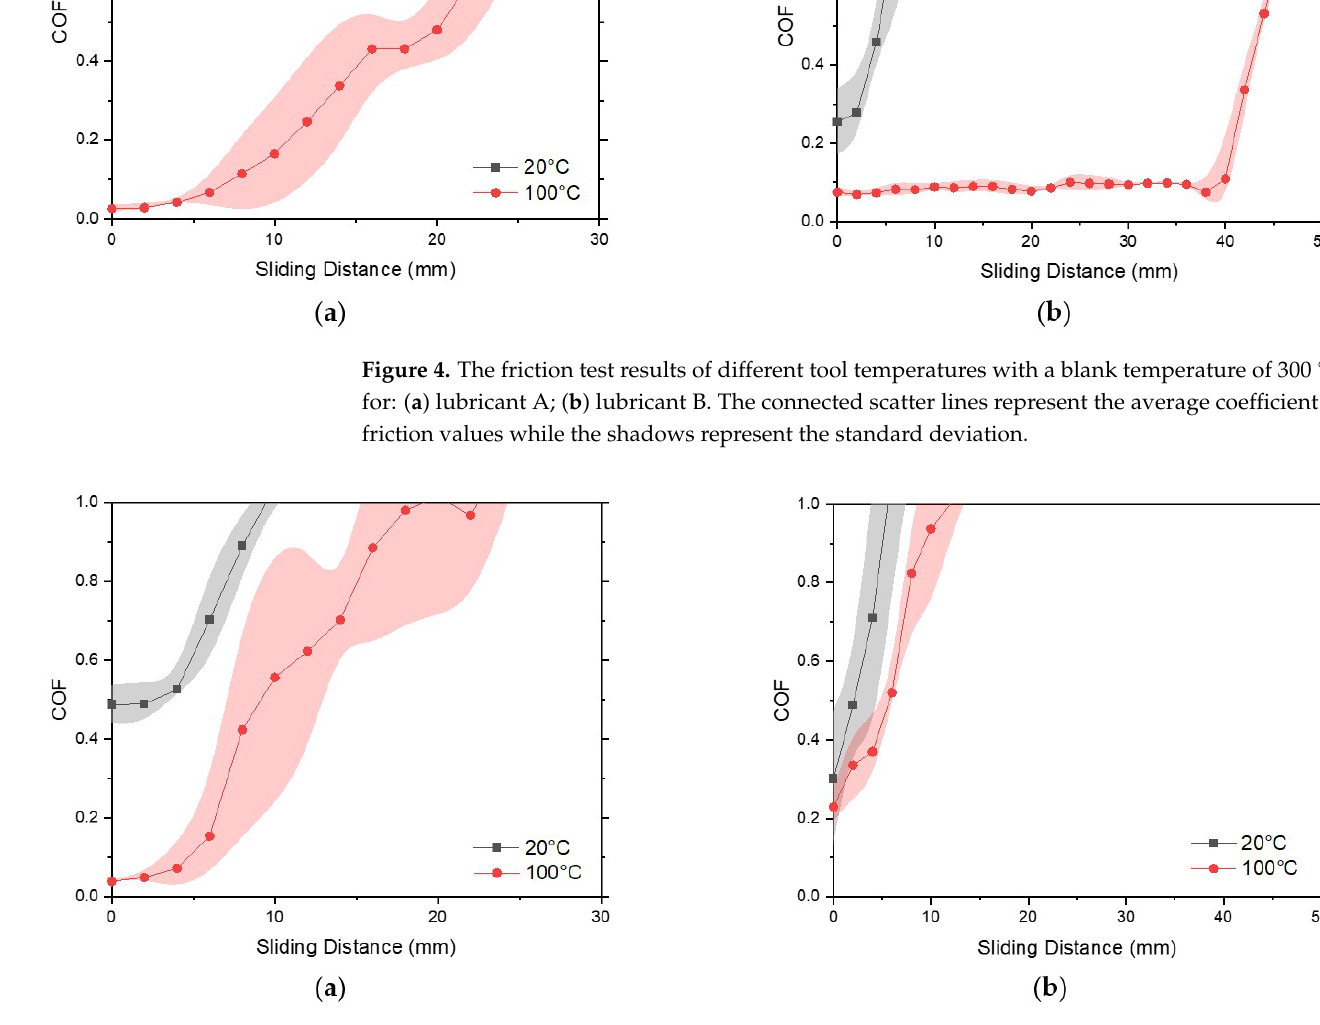
Figure 5. The friction test results of different tool temperatures with a blank temperature of 350 °C for: ( a ) lubricant A; ( b ) lubricant B. The connected scatter lines represent the average coefficient of friction values while the shadows represent the standard deviation.